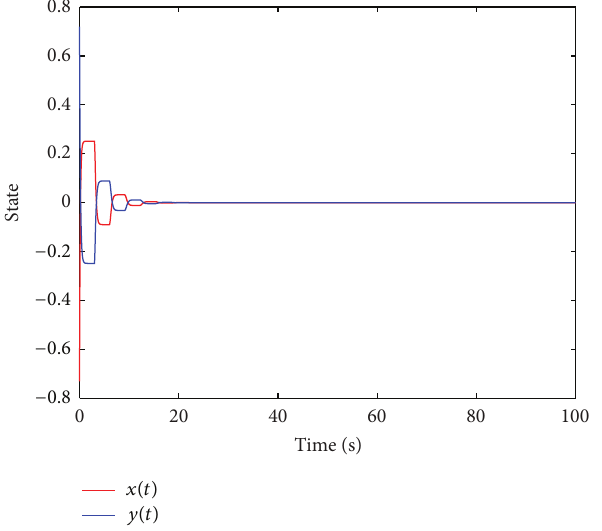
Figure 6: Simulation of the system (75) under the full impulsive